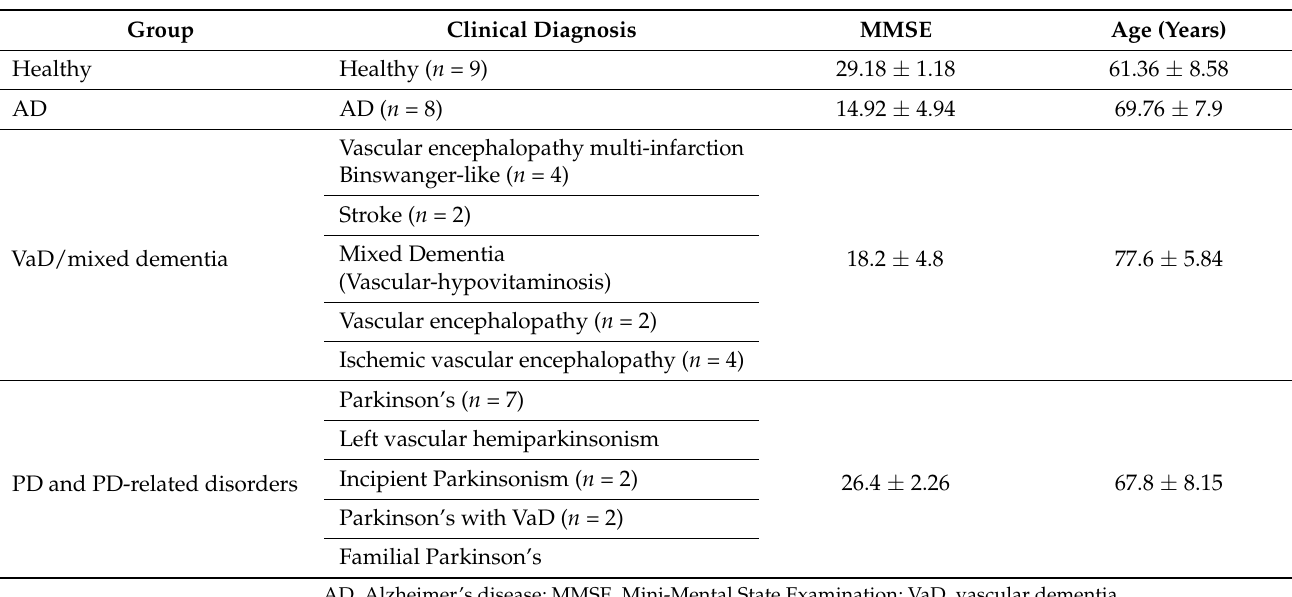
Table 1. Patient demographics and clinical diagnosis.